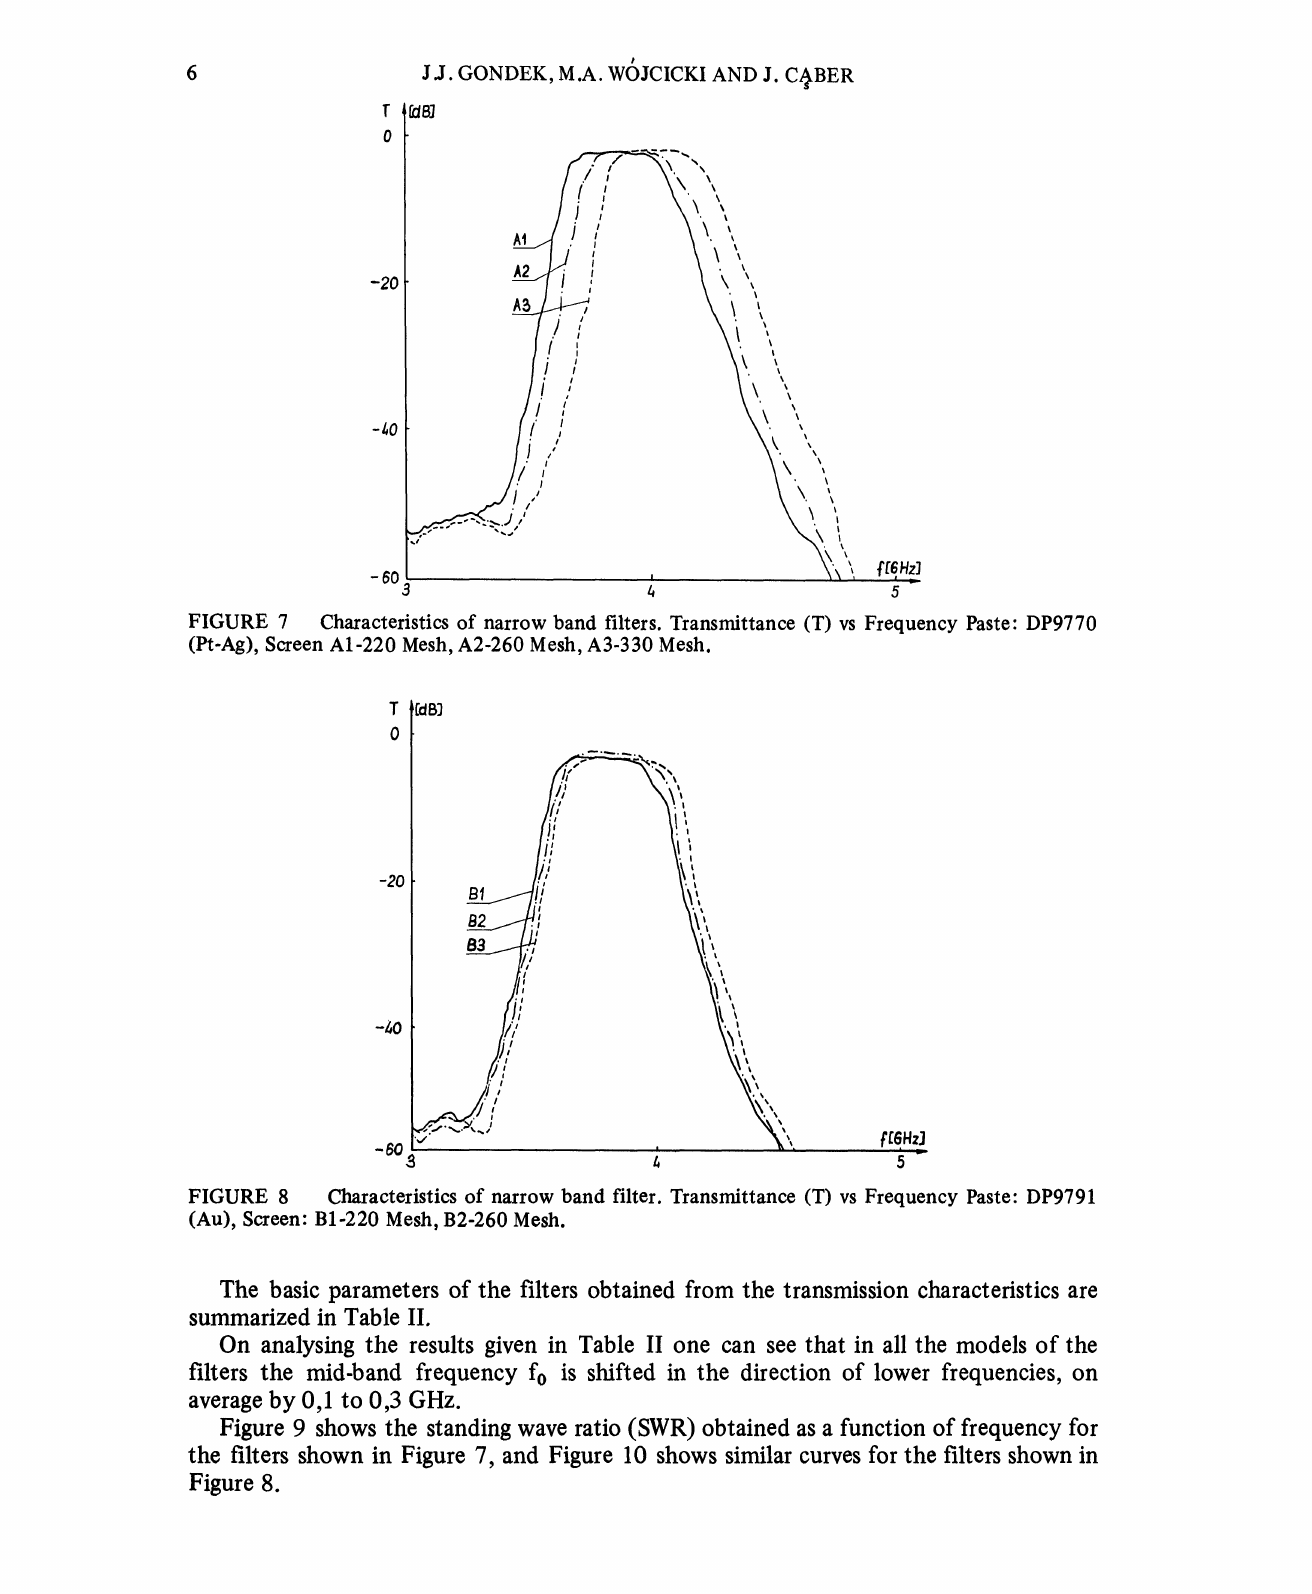
FIGURF 8 Characteristics of narrow band tilter. Transmittance (T) vs Frequency Paste: DP9791 Screen" B1-220 Mesh, B2-260